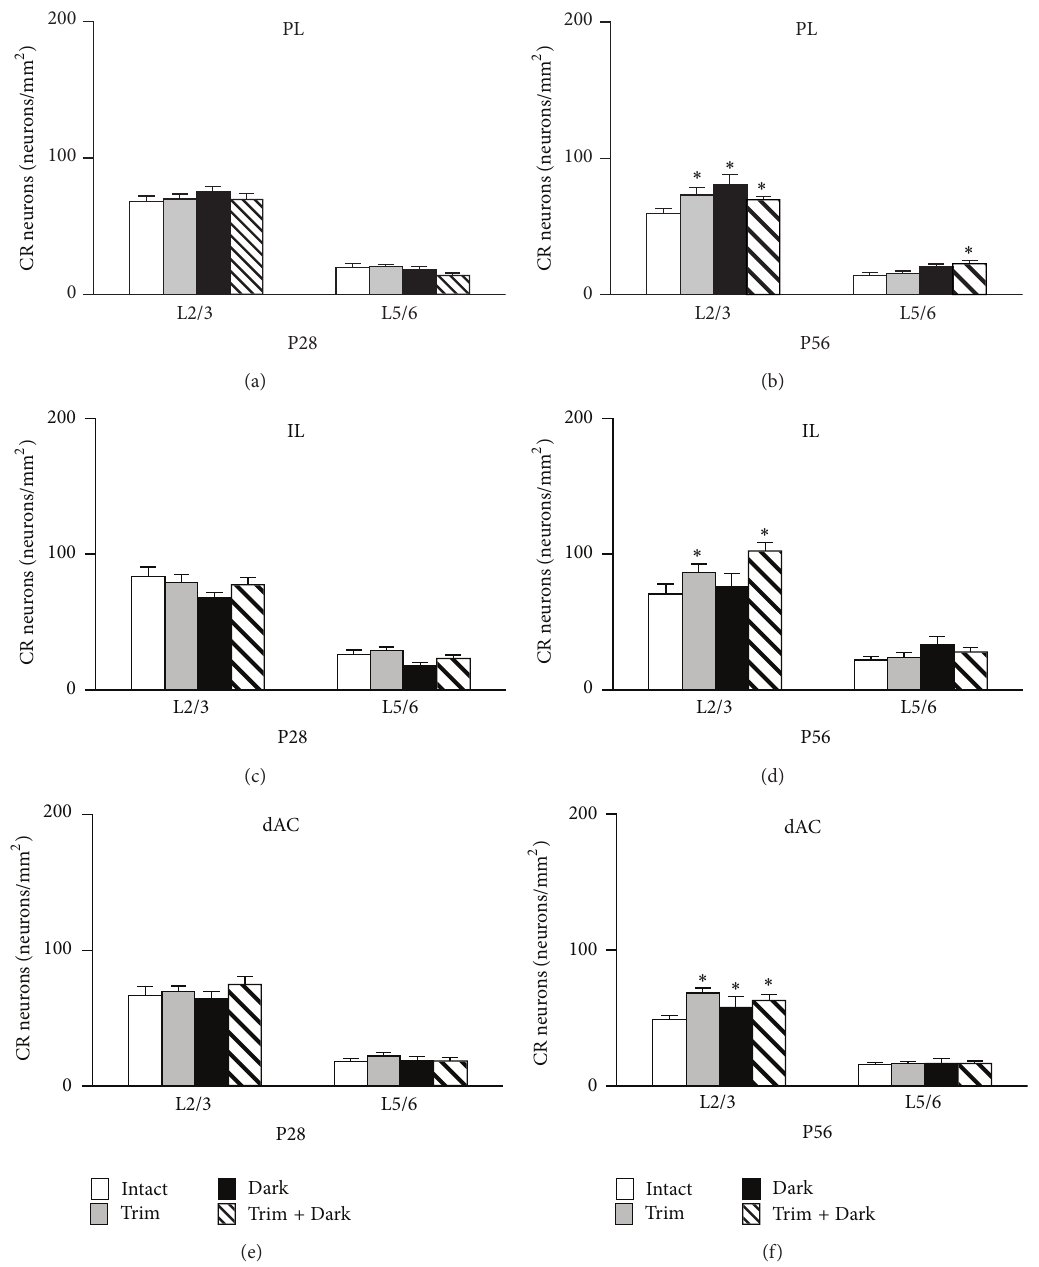
Figure 7: Sensory deprivation changes CR neuron density in the PFC. The density of CR neurons in the PL (a, b), IL (c, d), and dAC (e, f). CR neuron density at P28 (a, c, e) and P58 (b, d, f) in each area are shown. (a)-(b) There was no effect of sensory deprivation on the density of CR neurons in the PFC at P28. The density of CR neurons in L2/3 was increased by sensory deprivation at P56. (c)-(d) At P56 the density of CR neurons in L2/3 was increased by whisker trimming and dark rearing. (e)-(f) The density of CR neurons in L2/3 was increased by sensory deprivation at P56. Data are expressed as mean density S.E.M. ( 𝑛 = 6 per group). Abbreviations are the same as in Figure 4. ∗ 𝑃 < 0.05 compared with intact